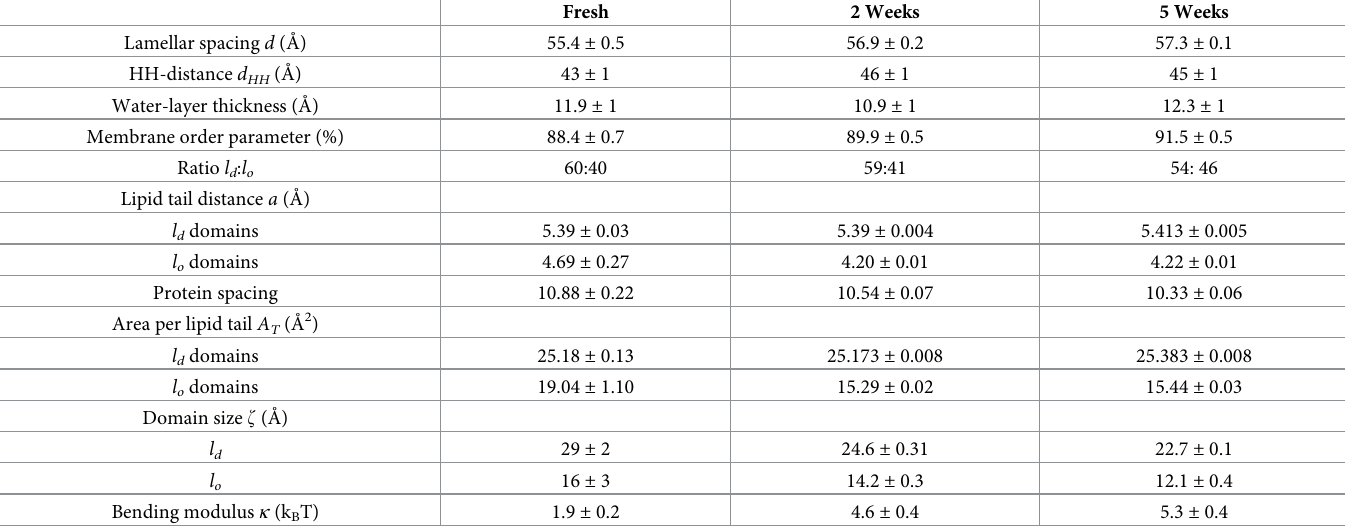
Table 1. Structural parameters and membrane bending modulus κ determined from XRD and XDS